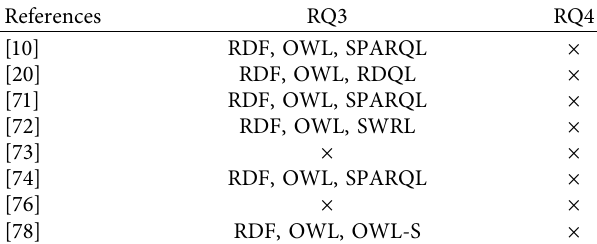
Table 7: Summary of Semantic Web technologies used in diseases.